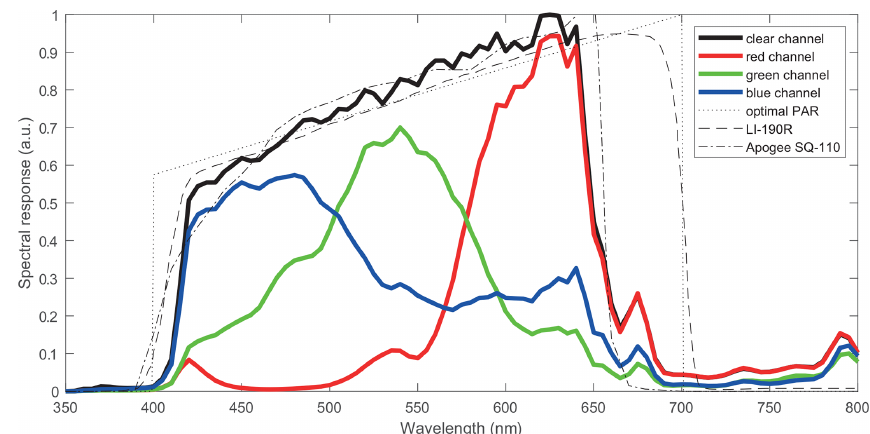
Figure 2. Spectral sensitivities of the red, green, blue and clear channel (solid lines). Thin black lines show the spectral sensitivities for different kinds of PAR sensors: theoretical PAR response (dotted line), LI-COR LI-190R sensor (dashed line) and Apogee SQ-110 silicon photodiode sensor (dash dotted